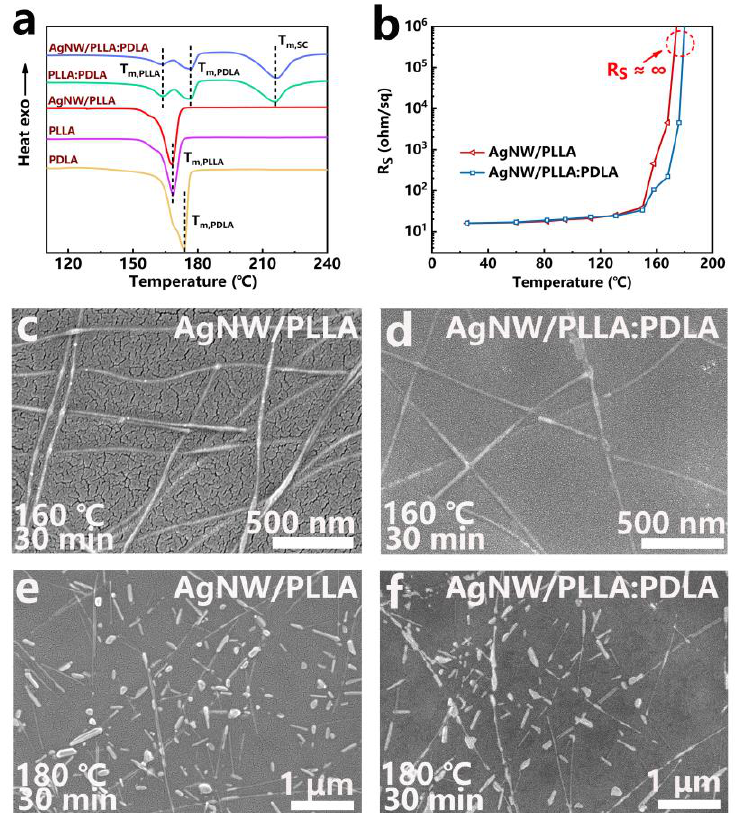
Figure 3. ( a ) DSC measurements of the PDLA, PLLA, AgNW/PLLA, PLLA:PDLA, and AgNW/PLLA:PDLA films. ( b ) Variations of the R S of the AgNW/PLLA and AgNW/PLLA:PDLA films as a function of the annealing temperature (the annealing time is 30 min). ( c – f ) SEM images of the cooled down AgNW/PLLA and AgNW/PLLA:PDLA films after annealing at 160 °C or 180 °C for 30 min.